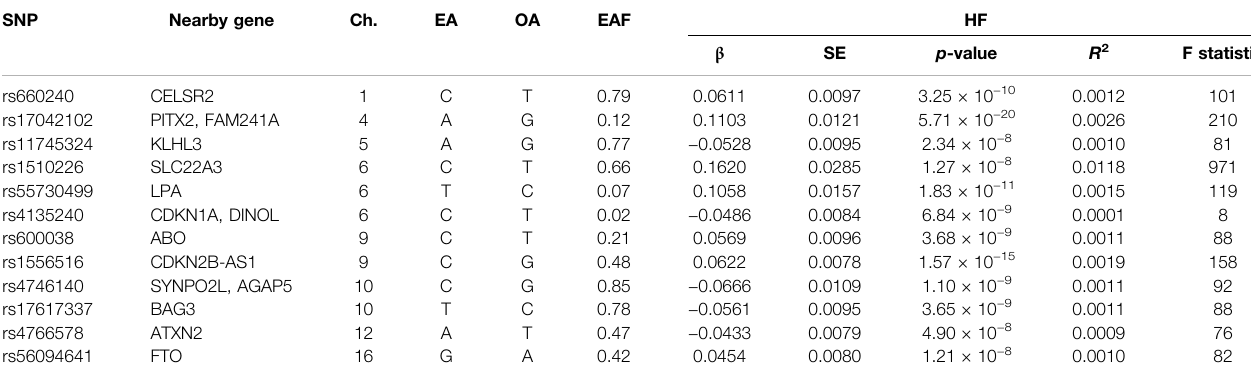
TABLE 1 | Included SNPs that are signi fi cantly associated with heart failure. SNP